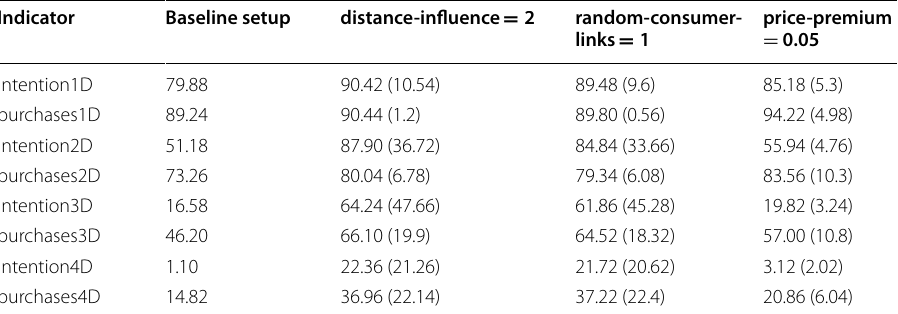
Table 8 Observed indicators at t = 50 for baseline and modified setups, parameters modified individually. In brackets, difference with baseline values (as indicators are normalised to represent percentages of the population, this difference represent the increase in the respective proportions).